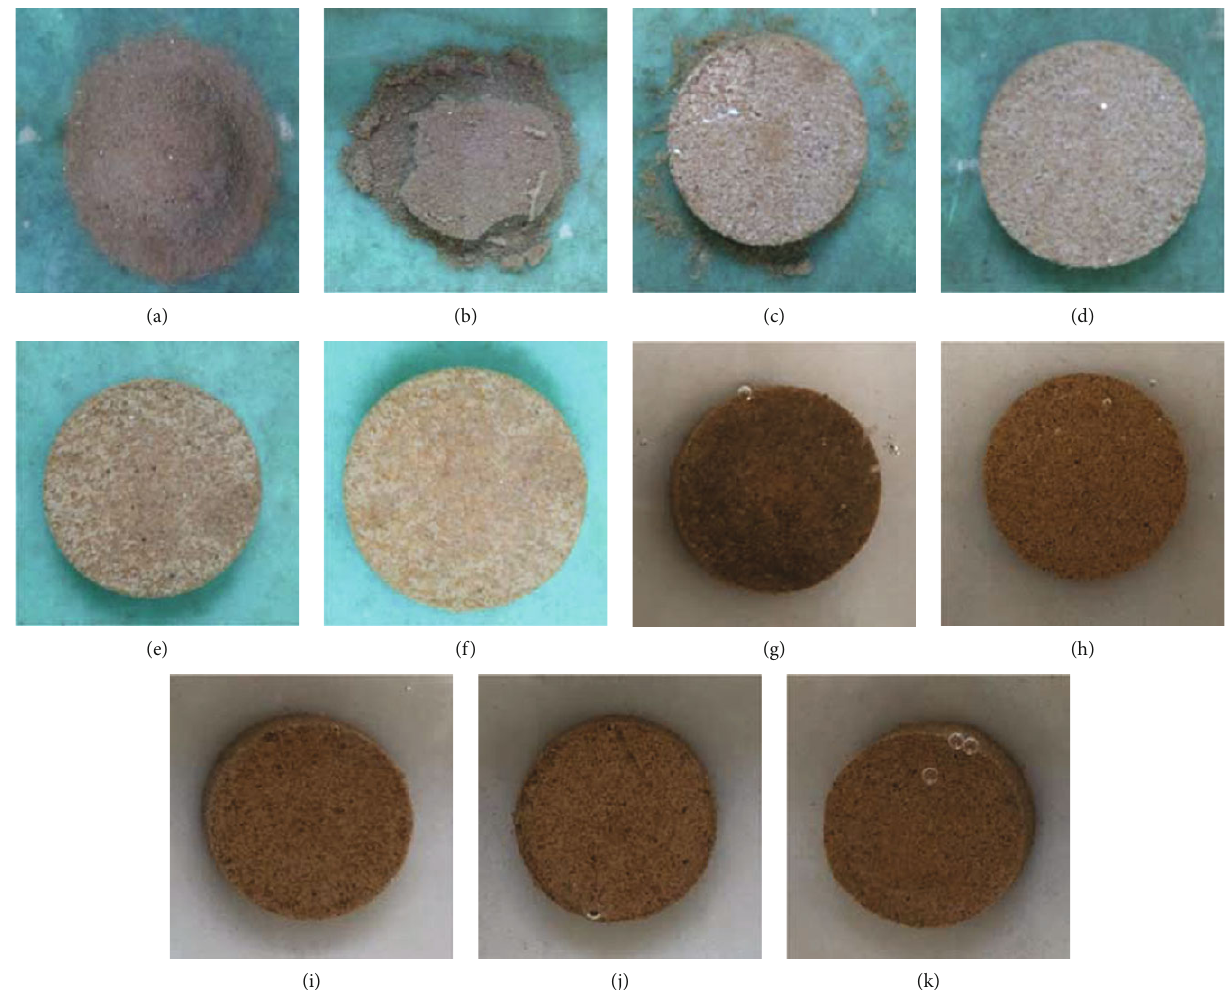
Figure 2: The disintegration of the specimens with di ff erent PU content: (a) 0%; (b) 0.1%; (c) 0.2%; (d) 0.3%; (e) 0.4%; (f) 0.5%; (g) 1%; (h) 2%; (i) 3%; (j) 4%; (k)